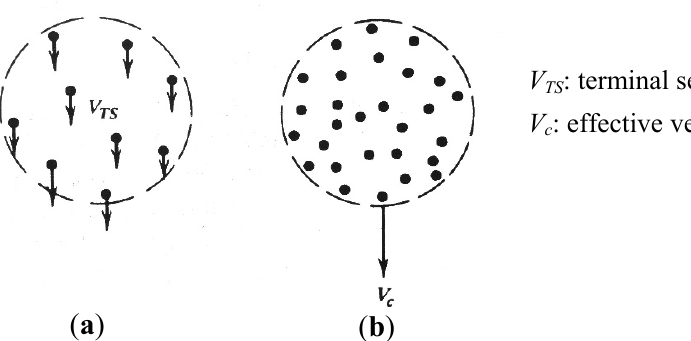
Figure 5. General sketch of: ( a ) Individual particle motion ( b ) Cloud motion (adapted from [127], with permission of John Wiley & Sons,